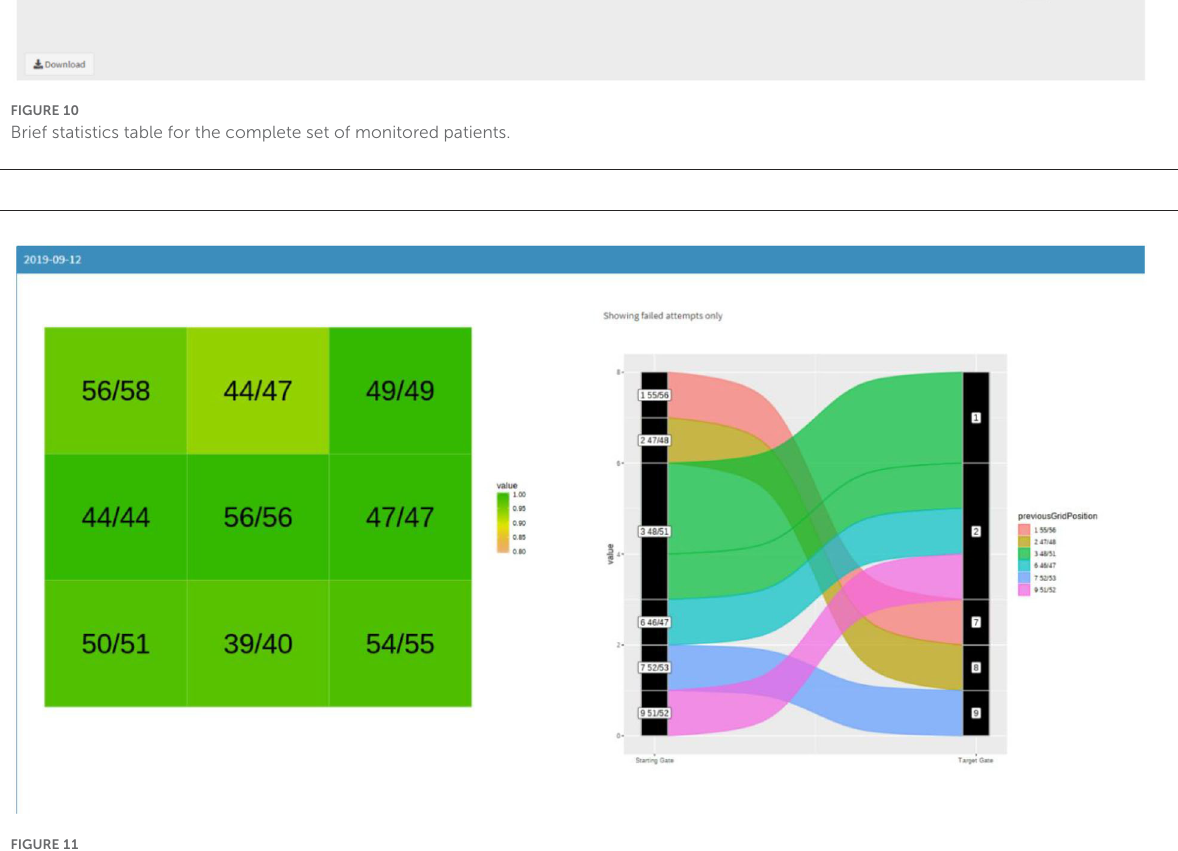
as healthy or pathologic, a two-phase procedure was